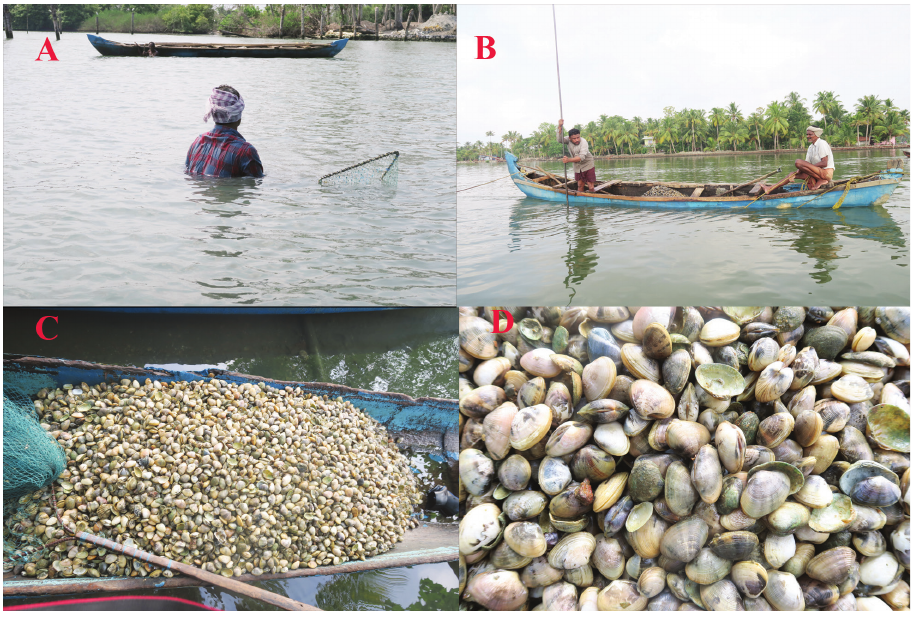
Figure 2. Small scale clam fishery in Ashtamudi Lake, Kerala, India A collecting by hand picking B col- lecting using a dredge net C, D a typical catch of